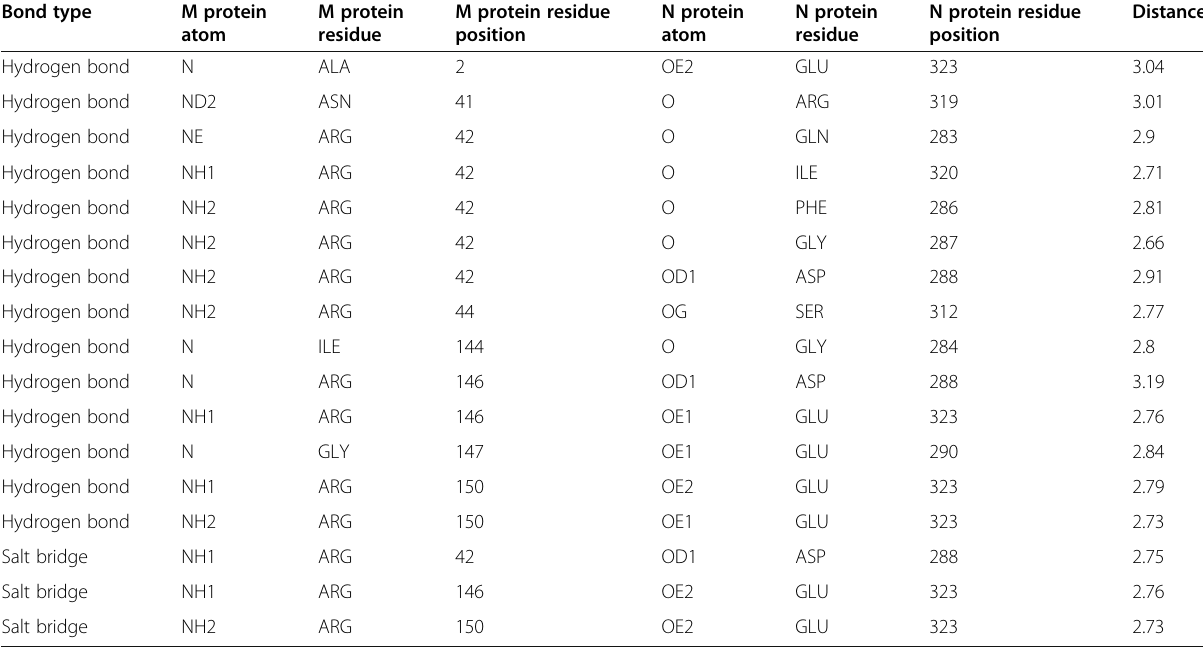
Table 1 Residues involved in hydrogen bonds and salt bridges between the mutant N protein and the M